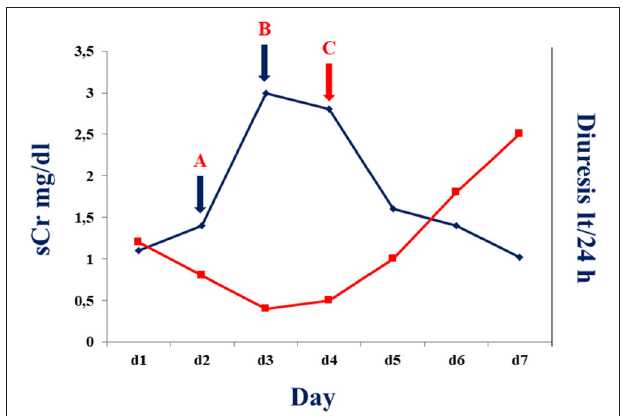
FIGURE 1 | Serum creatine (blue line) and diuresis (red line) before and after tocilizumab administration in the described patient. A: Serum creatinine and diuresis at time of 50% cyclosporine dose reduction. B: Serum creatinine and diuresis at time of withdrawn cyclosporine administration. C: Serum creatinine and diuresis after 24–48h of tocilizumab administration.